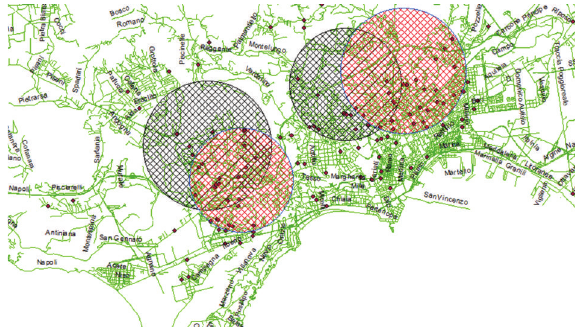
Figure 7: Edema of bilateral Reinke disease—year 2012: display of the hotspots on the map.